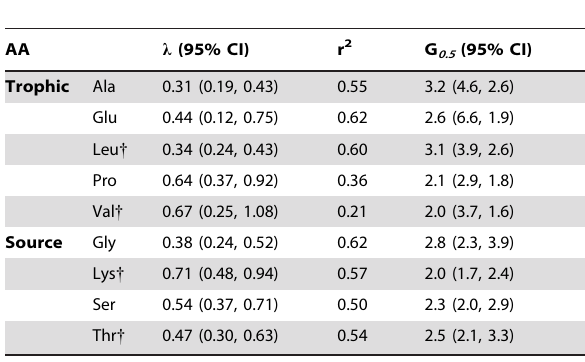
Table 4. Amino acid 15 N incorporation rates and growth- based half-life (G 0.5 ) estimates for exponential fit models of relative growth (W R ) with 95% confidence intervals in Pacific bluefin tuna ( Thunnus orientalis